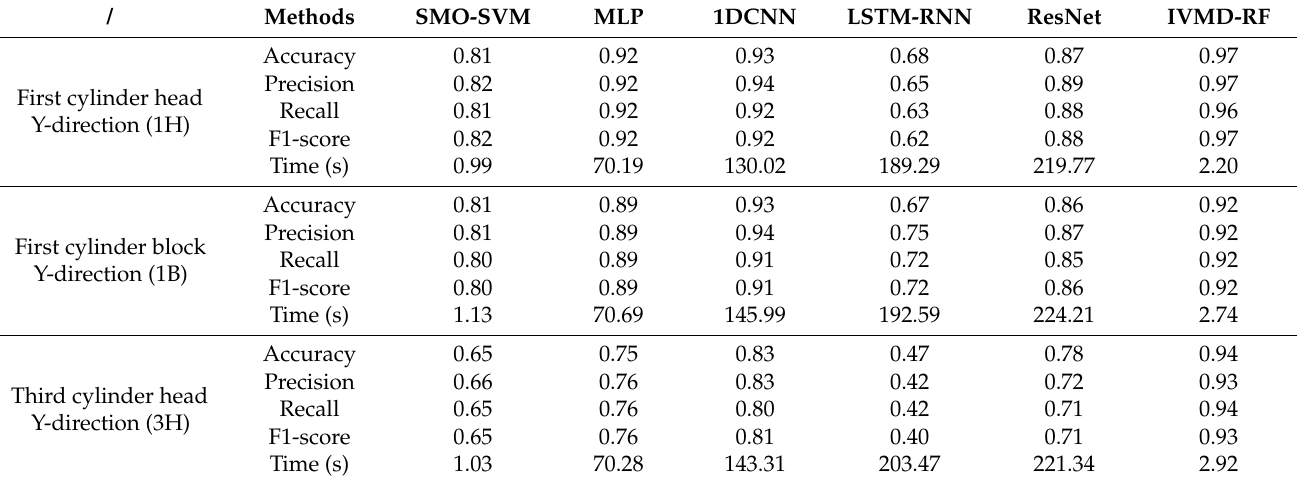
Table 8. Comparison of fault diagnosis results of each algorithm for cross-speed